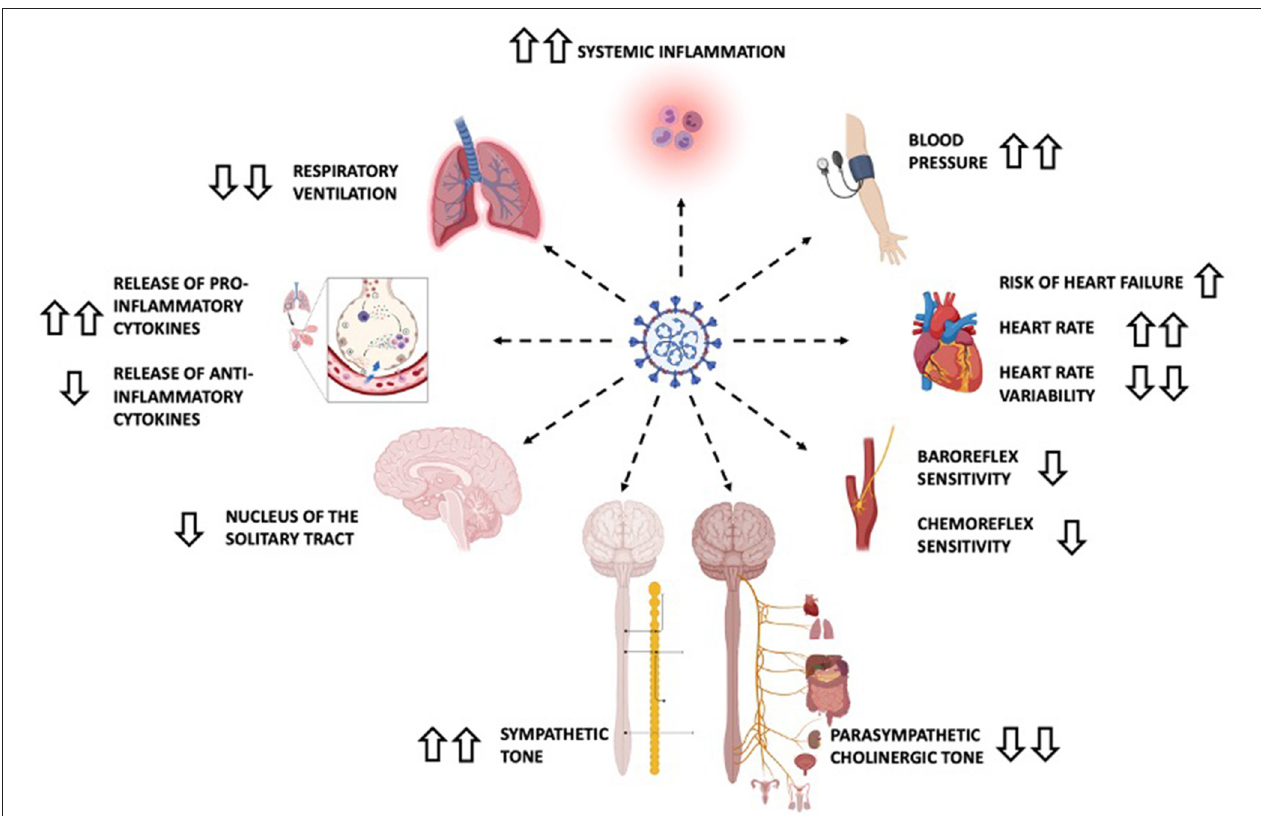
FIGURE 3 | Main dysautonomic changes in severe COVID-19 infection. Information extracted from the text and based on the article by Rangon et al. (27). Upward and downward pointing arrows indicate increase and decrease, respectively. Double arrows indicate important variations. Recording hemodynamic changes and detailed neurologic examinations are both standard clinical practice but are of the utmost importance in patients with COVID-19 and manifestations suggestive of autonomic